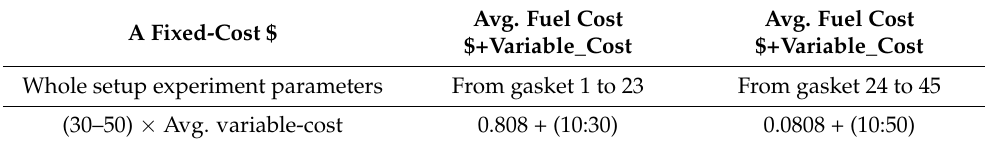
Table 4. TEG-IEC fixed and variable-cost ranges. A Fixed-Cost $